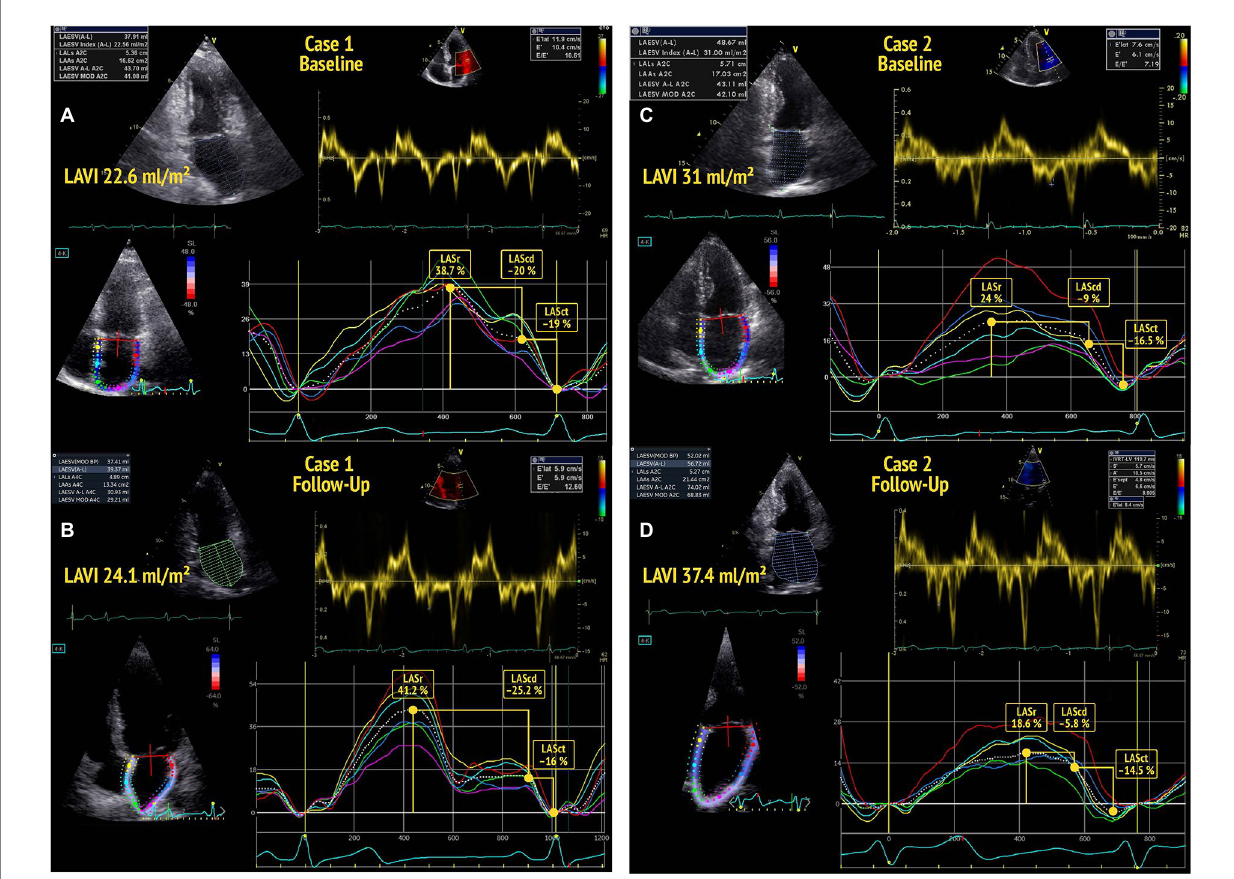
FIGURE 1 Baseline echocardiography of two participants (A,C) showing normal left atrial volume index (LAVI) (<34 ml/m 2 ) and normal diastolic function according to the 2016 ASE guidelines. The participant in A shows a left atrial reservoir strain (LASr) >34% at baseline and no deterioration of diastolic function by the time of follow-up (B) . The participant in C presents with a low baseline LASr and shows a decline of diastolic function (DD0 to DD1) by the time of follow-up echocardiography (D)